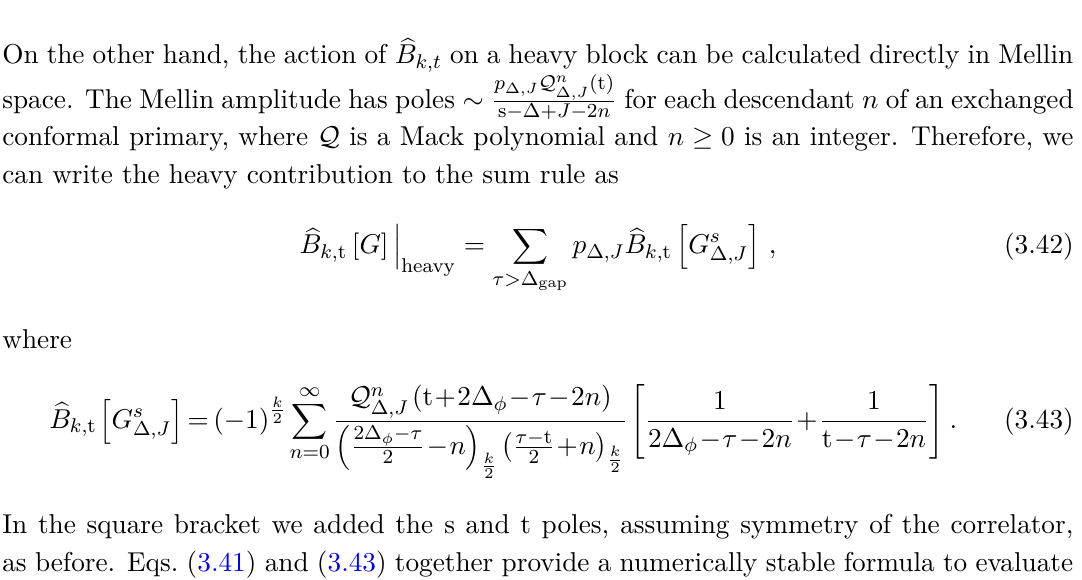
Figure 10. Convergence in the Regge limit: m → ∞ with ν and η AdS fixed. The dots show numerical evaluation of the Mellin representation (3.46), divided by the leading order formula [∆ , J ] = 2 ( η ) , so as to asymptote to 1. The solid line shows the leading 1 /m 2 C (0) P AdS 2 − d 2 ,ν + iν m 4 2 correction from (3.27), which is seen to track the exact result even at moderate m ≈ 10